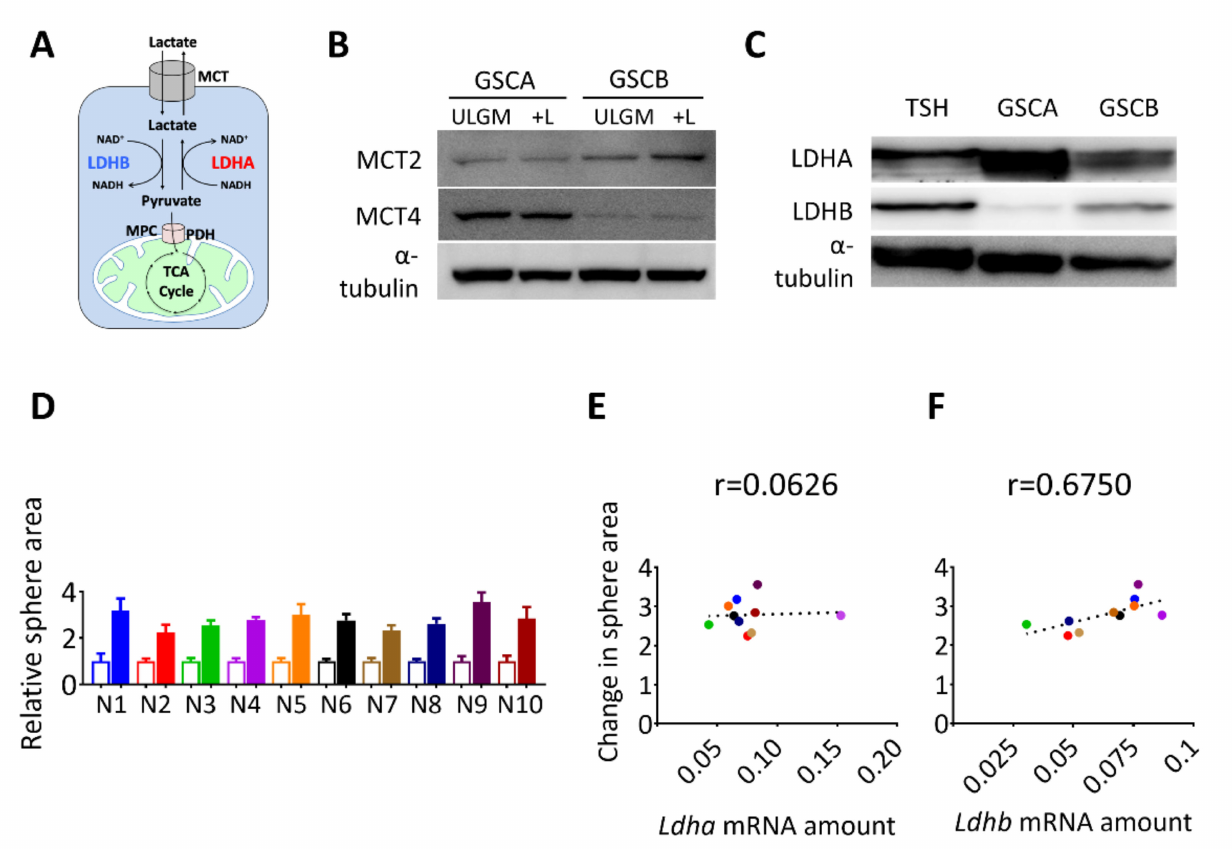
Figure 2. Expression of lactate dehydrogenase B (LDHB) correlates with the rescue effect of lactate in glucose-deprived GSCs. ( A ) Schematic representation of lactate uptake and lactate-pyruvate interconversion. ( B ) Immunoblot analysis of monocarboxylate transporter 2 (MCT2), MCT4, and α -tubulin (loading control) in GSC cell lines (GSCA and GSCB) cultured in ULGM or ULGM supplemented with 4 mM lactate (+L). ( C ) Immunoblot analysis of LDHA and LDHB in GSC cell lines (GSCA, GSCB, and TSH) cultured in normal medium. ( D ) Relative sphere area for TSH-derived clones (N1–N10) cultured for 7 days in ULGM (open bars) or ULGM supplemented with 4 mM lactate (filled bars). ( E , F ) Correlation plots of Ldha ( E ) or Ldhb ( F ) mRNA levels and lactate-induced sphere growth determined as in ( D ) for TSH clones N1 to N10. Quantitative data are means ± SD for 10-12 spheres from one representative experiment and were subjected to Pearson correlation ( r )